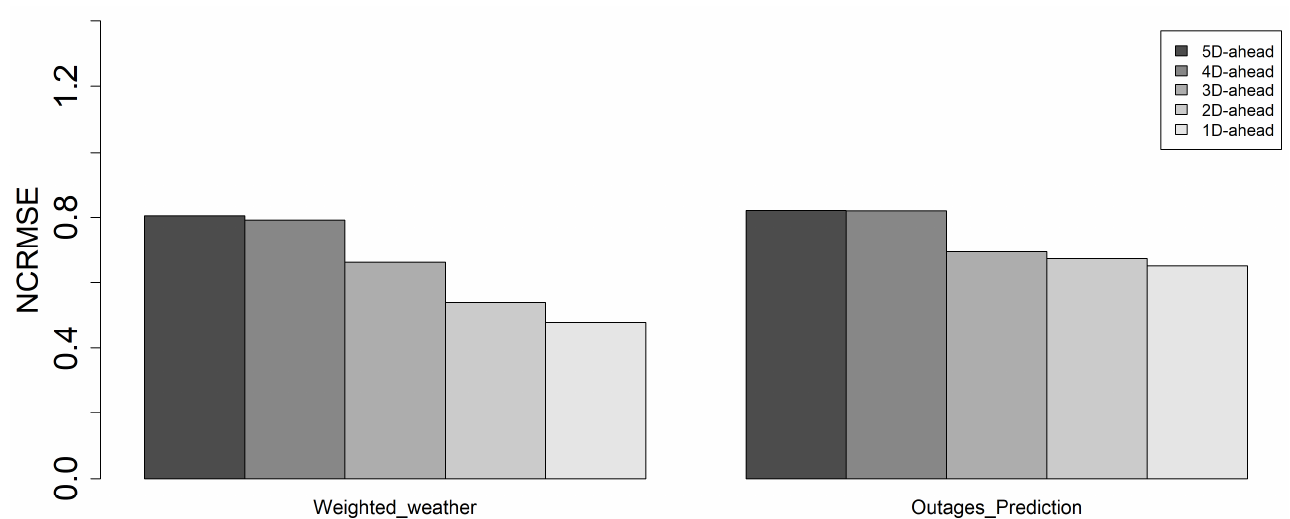
Figure 8. NCRMSE ratio of weighted weather to outage prediction for different lead times.